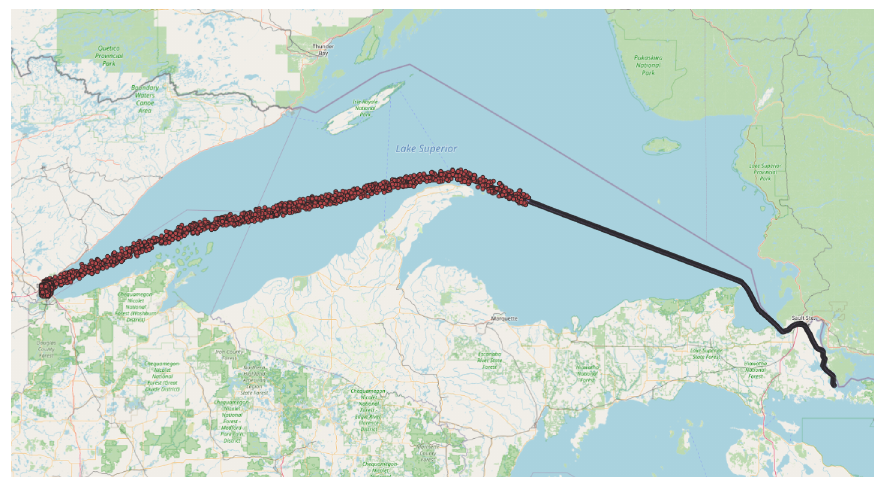
Figure 10. The route prediction results with MICE.